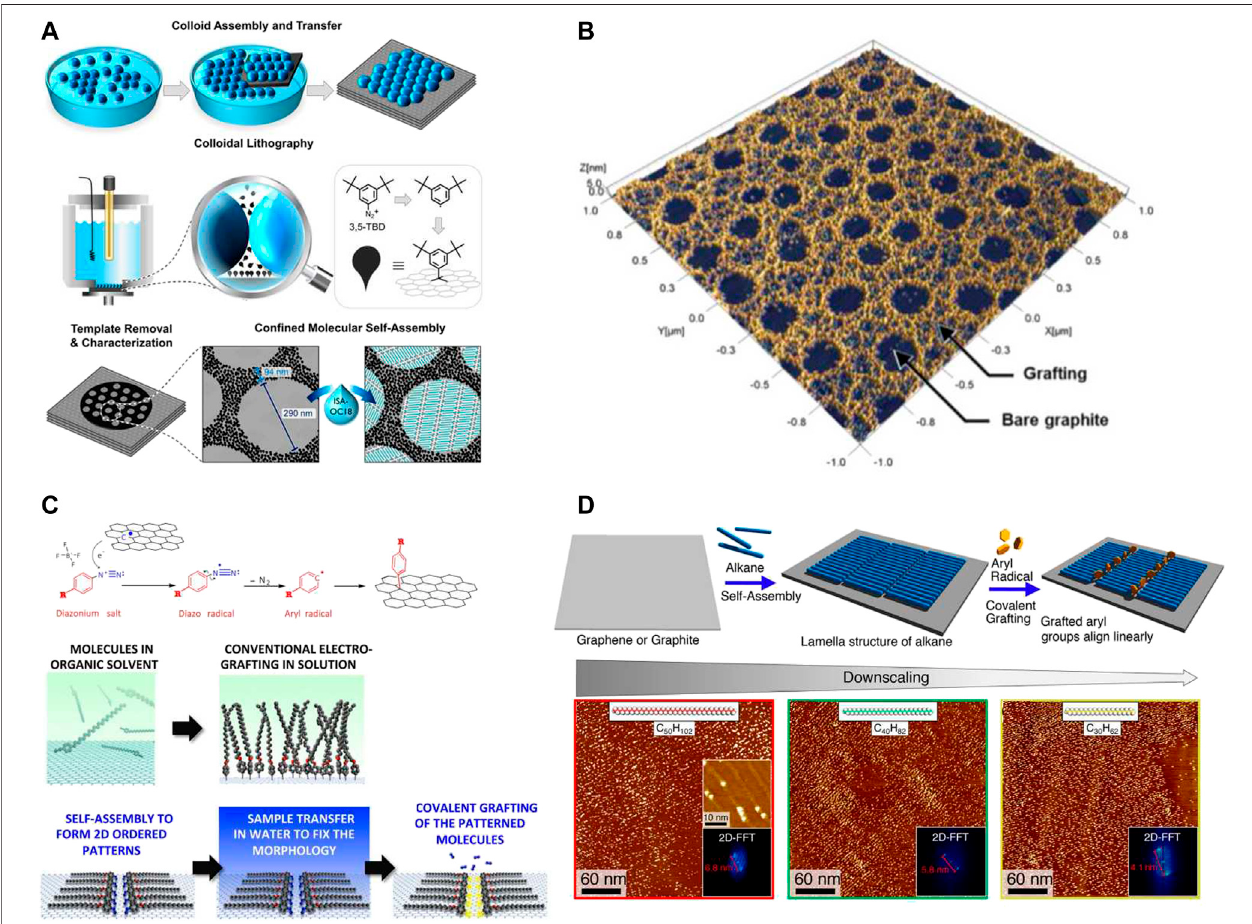
FIGURE 2 | Covalent patterning of graphene with a nanoscale patterning resolution. (A) Schematic demonstration of the colloidal lithography method to generate covalently formed nanocorrals on the HOPG substrate for con fi ned molecular self-assembly. Panel adapted with permission from Van Gorp et al., (2018). Copyright: American Chemical Society. (B) Covalent patterning of graphitic substrates with the assistance of electrochemically in situ -generated products and nanobubbles as the template. Panel adapted with permission from Phan et al., (2019). Copyright: American Chemical Society. (C) Schematic illustration of covalent patterning on graphitic surfaces via the pre-assembled monolayer of p-(n-octadecyloxy) benzene diazonium, followed by electrochemical activation. Panel adapted with permission fromXiaetal.,(2016).Copyright:AmericanChemicalSociety. (D) SchematicillustrationofcovalentpatterningofHOPGusingself-assembledmonolayersofalkaneswith tunable length as templates and corresponding STM images with Fourier transforms. Panel adapted with permission from Tahara et al., (2018). Copyright: American Chemical Society.